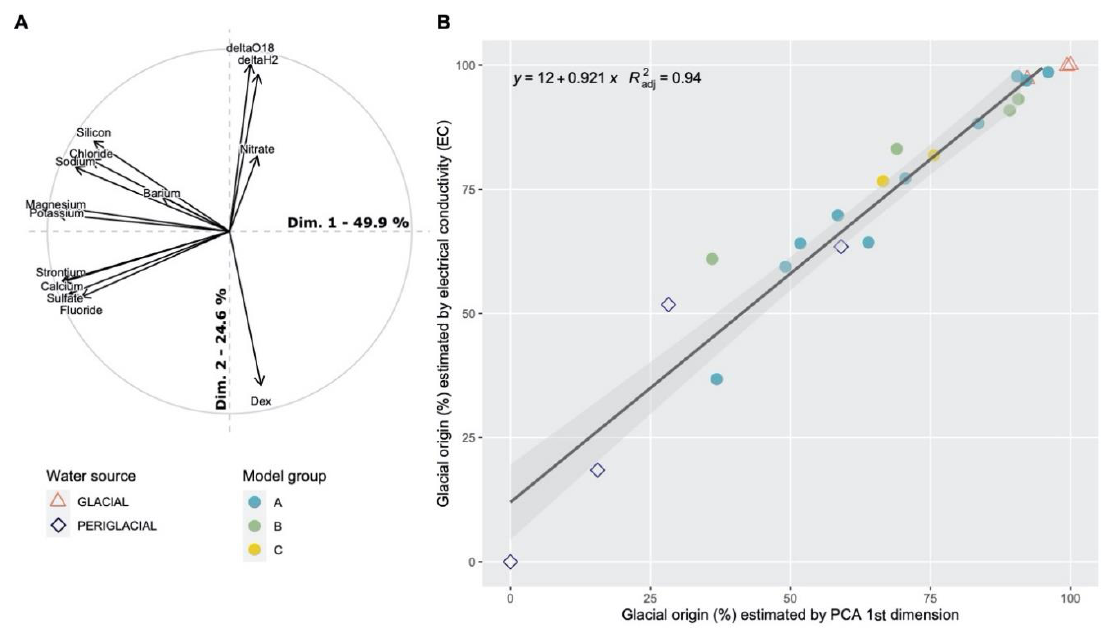
Figure 2. Principal component analysis (PCA) based on both ionic (nitrate, chloride, sodium, silicon, barium, potassium, magnesium, fluoride, calcium, strontium, sulfate) and isotopic (deltaO 18 : δ 18 O, deltaH 2 : δ 2 H, Dex: deuterium excess) data. ( A ) Correlation circle positioning the variables studied. The correlation of the electrical conductivity values and the coordinates of the first dimension of the PCA ( B ) highlighted that electrical conductivity is suitable for glacial/periglacial origin